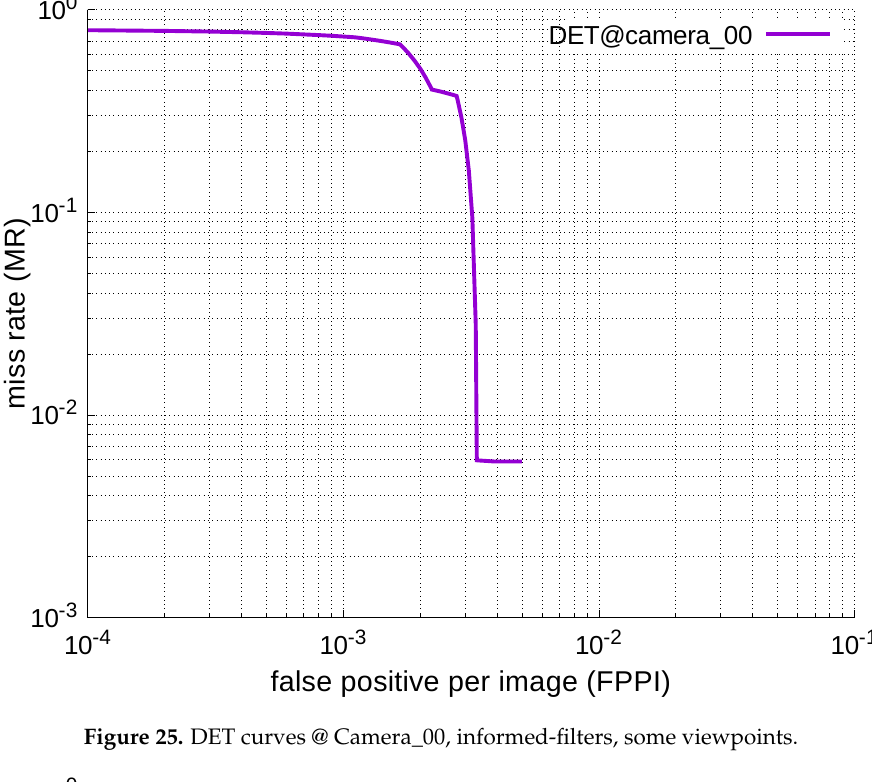
Figure 25. DET curves @ Camera_00, informed-filters, some viewpoints.